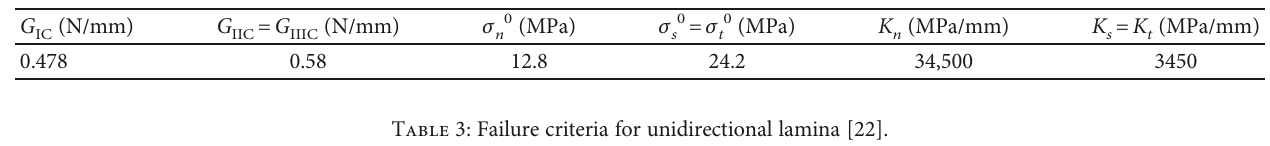
Table 2: The properties of the cohesive layer